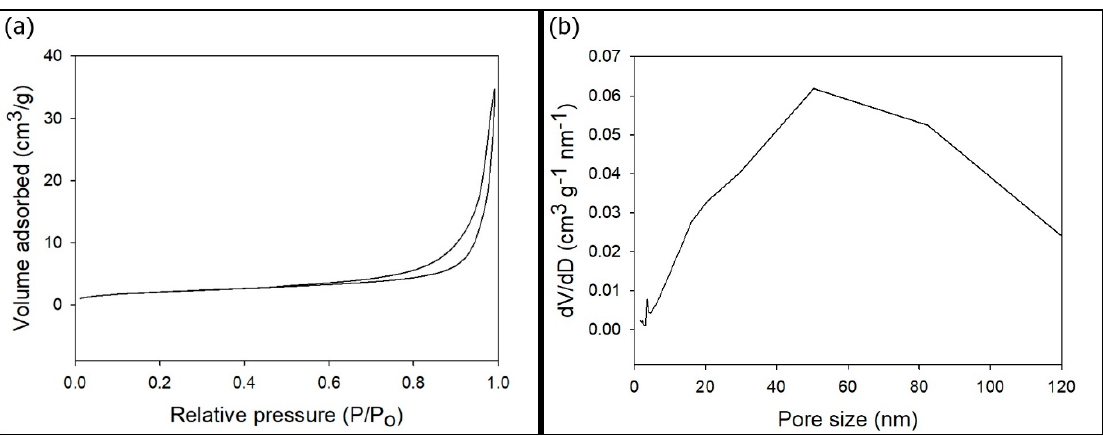
Figure 5. ( a ) N 2 adsorption–desorption isotherm and ( b ) pore size distribution curve of p-HApFs.